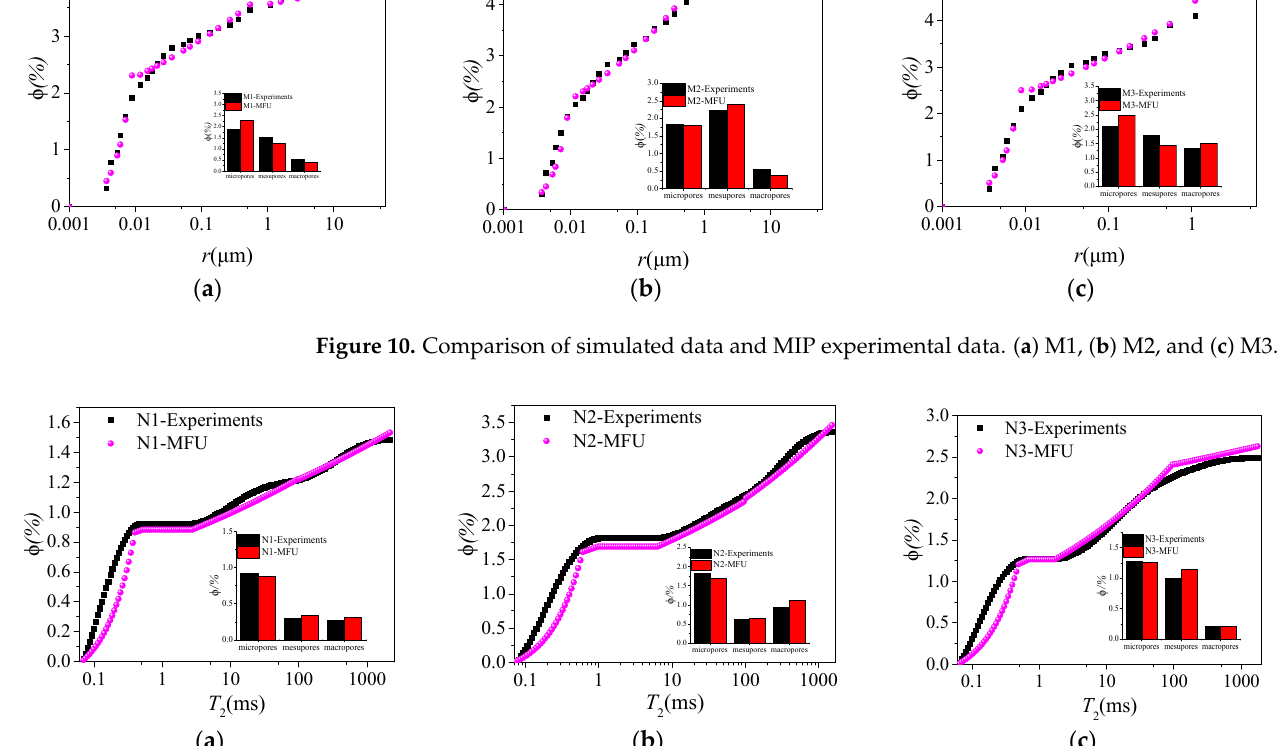
Figure 11. Comparison of simulated data and NMR experimental data. ( a ) N1, ( b ) N2, and ( c ) N3.